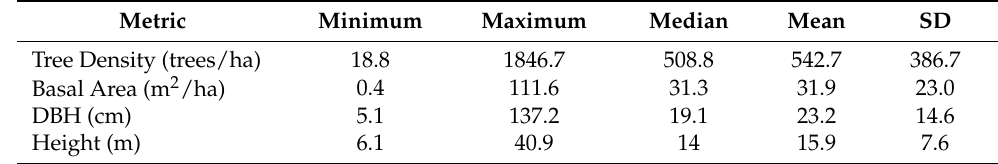
Table 1. Tree measurement summary statistics for the validation inventory plots. Metric Minimum Maximum Median Mean Tree Density